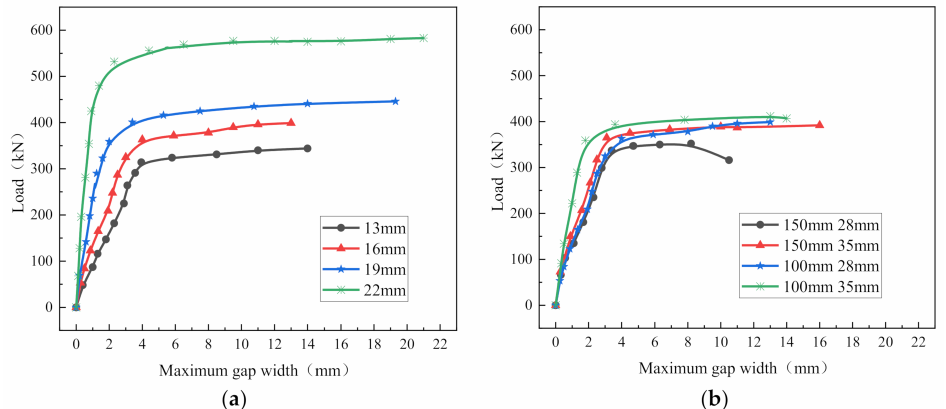
Figure 11. Steel–ECC top interface load–gap width curve: ( a ) 100 mm pitch, 35 mm length studs; ( b ) 16 mm